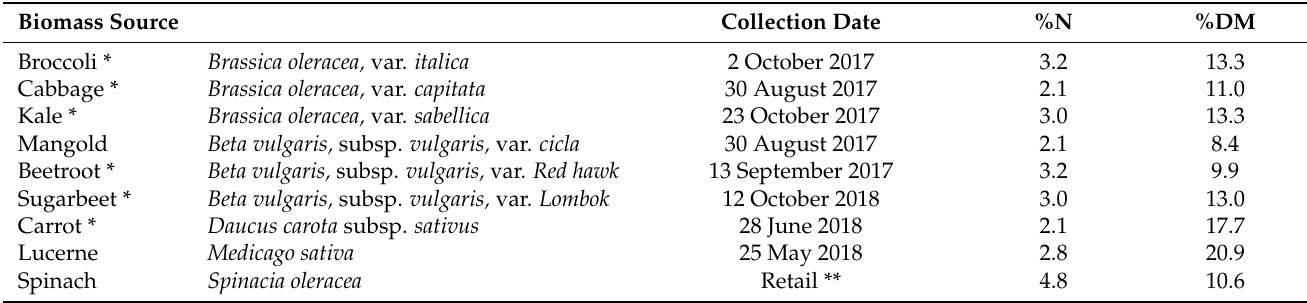
Table 1. The nine types of agricultural green biomass evaluated in this study and their nitrogen (N) content on a dry matter (DM) basis.